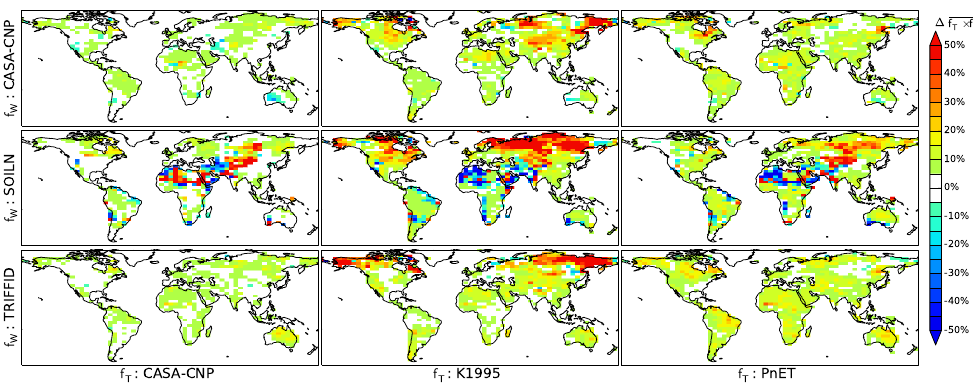
Fig. 6. Change in the average f W × f T product between the periods 1850–1859 and 1995–2005 relative to its initial value in CN simulations (in %). Positive values mean that the product is greater at the end of the historical simulations than at the beginning.